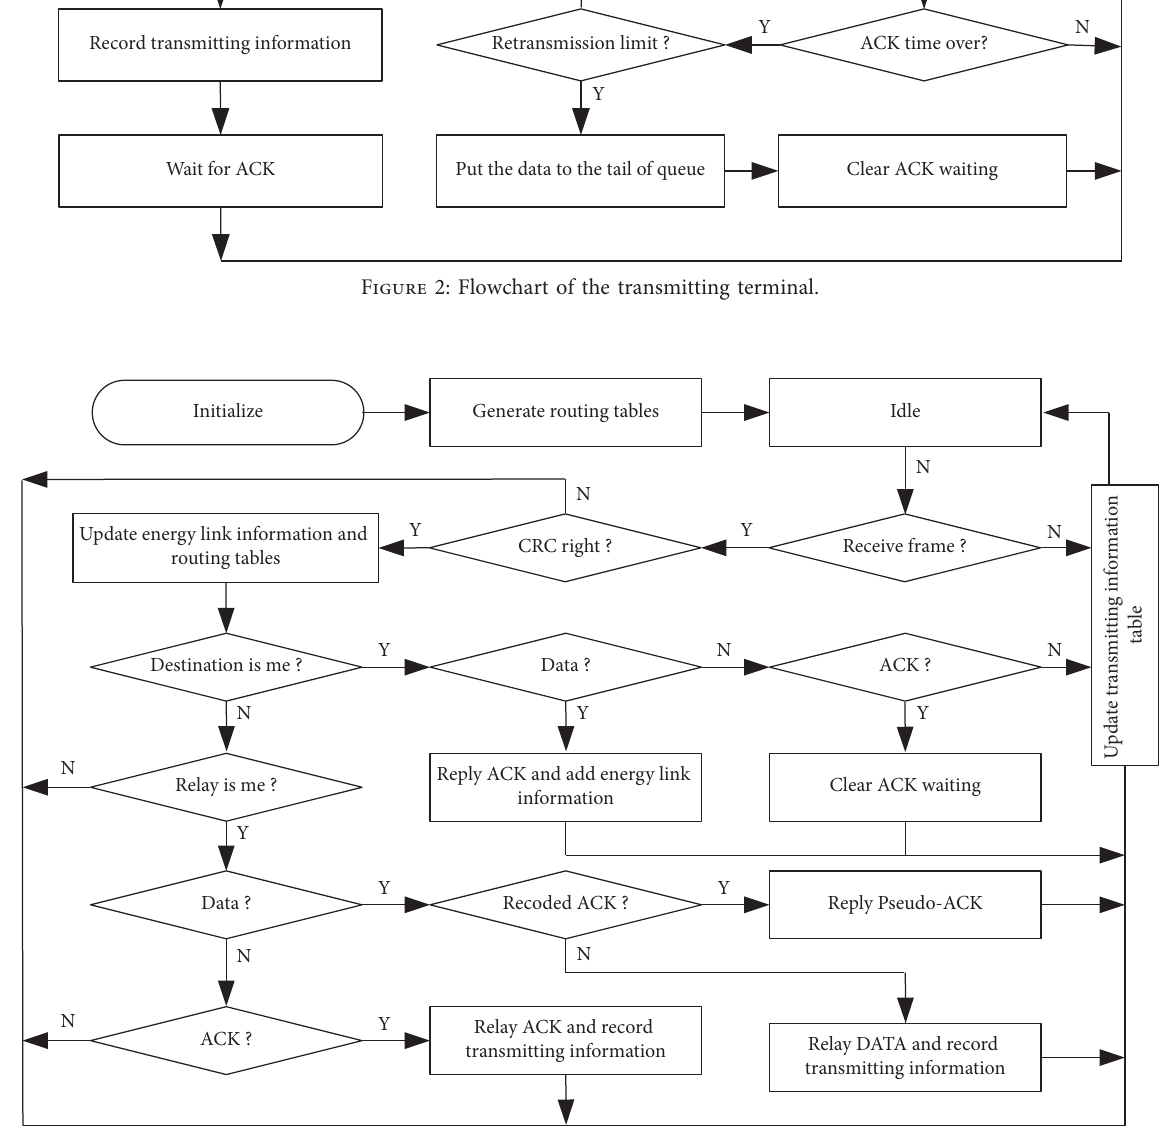
Figure 3: Flowchart of the receiving